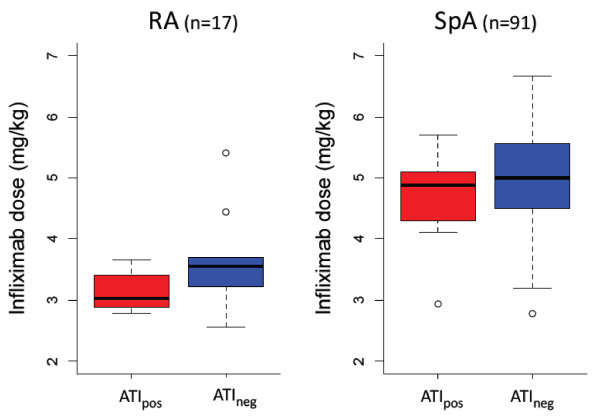
Initial infliximab dose for patients positive and negative for antibodies toward infliximab (ATIpos and ATIneg, respectively). Box plots show the medians and interquartile ranges, and the whisker plots represent the 95th percentiles. Two patients in the RA subgroup (open circles) received 5 mg/kg infliximab at initiation because they were initially suspected of having psoriatic arthritis. During follow-up, anticitrullinated protein antibodies were detected in both patients, which explains their placement in the RA subgroup. Two patients with SpA (open circles) received 3 mg/kg infliximab at initiation because they had a peripheral form of the disease and were therefore misclassified as having RA. ATI: antibodies toward infliximab; ATIpos: ATI detected at least once during follow-up; ATIneg: ATI not detected; RA: rheumatoid arthritis; SpA: spondyloarthritis.